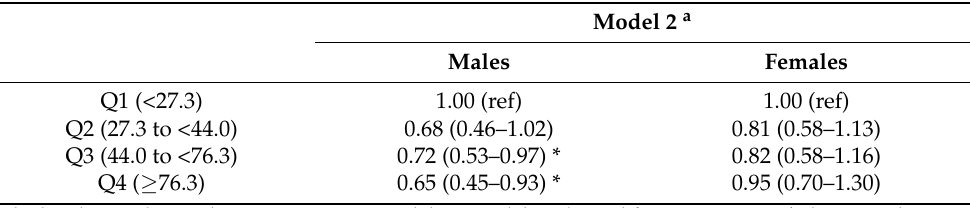
Table 3. Weighted odds ratios (95% confidence intervals) for daytime sleepiness across quartiles of pyridoxal 5 (cid:48) -phosphate (PLP) concentrations stratified by gender (NHANES 2005–2008).